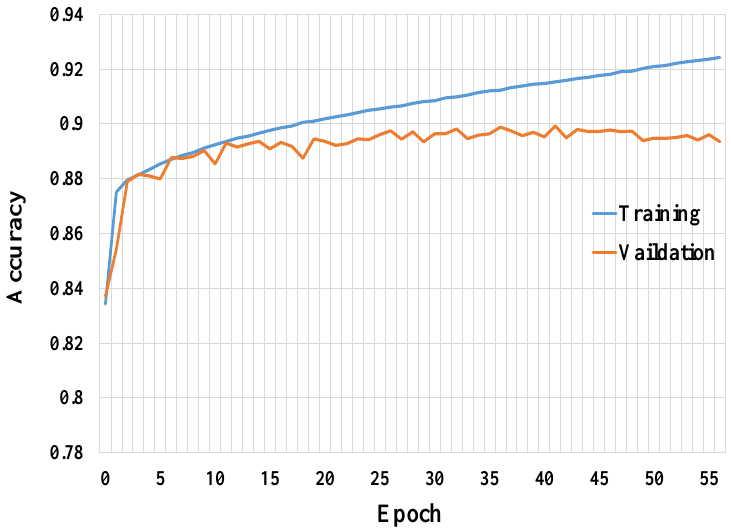
Figure 5. The training and validation accuracy curves of Connected-SegNets.